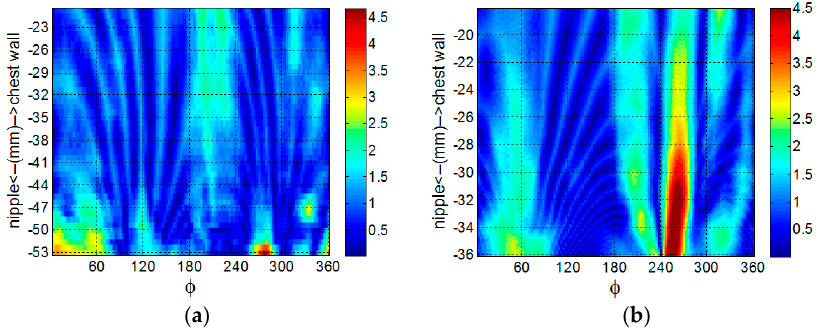
Figure 10. Map of distance error (in mm) over surface estimated with 20 profiles of: ( a ) model B, and ( b ) model C.